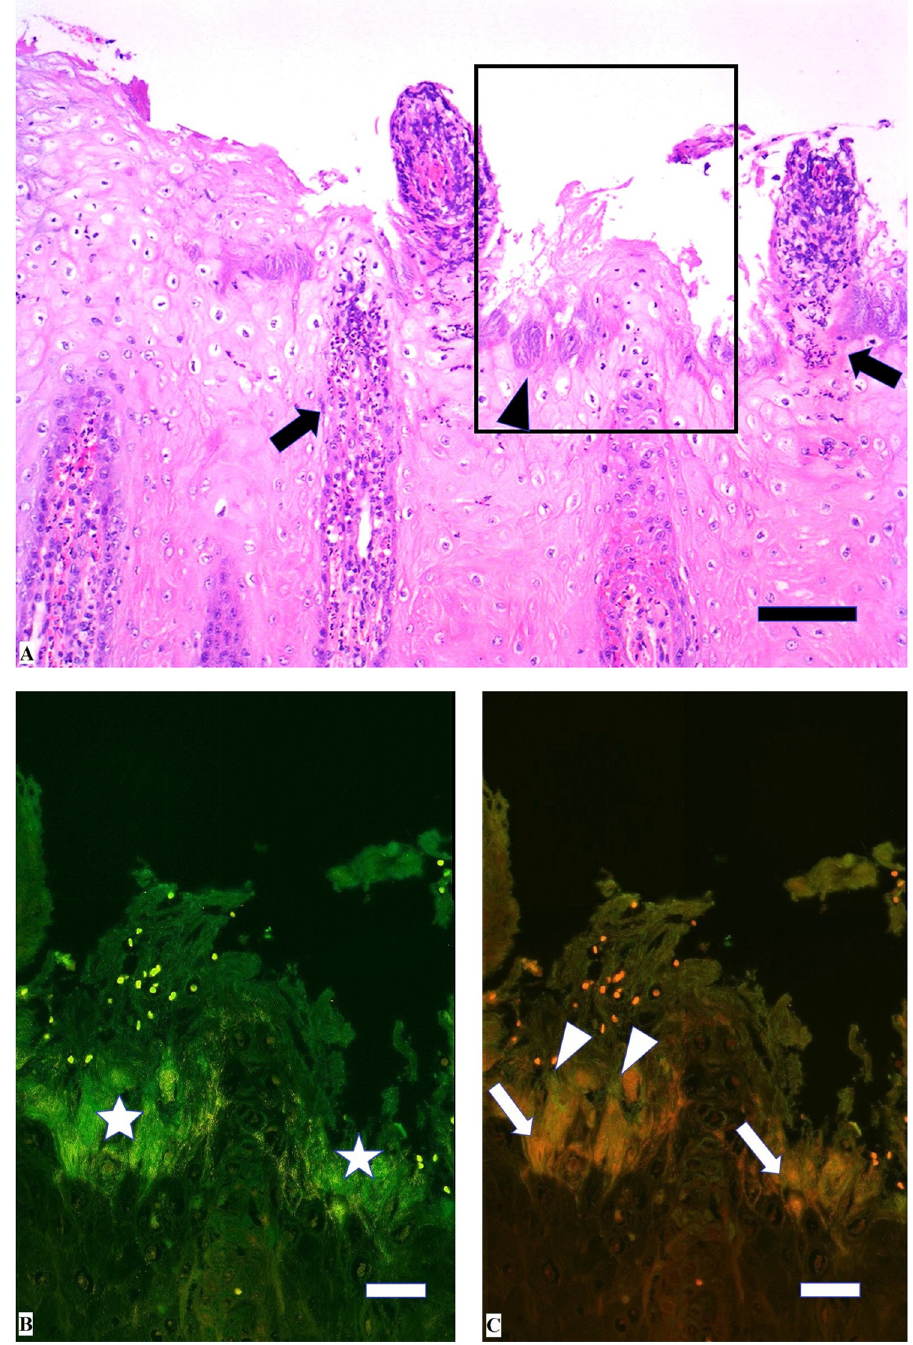
Fig 3. Histological appearance of interdigital skin of European bison ( Bison bonasus ) with digital dermatitis. Left hind foot of animal no. 7. A: The dermatitis is characterized by epithelial acanthosis, ballooning degeneration of keratinocytes and elongated, dermal papillae containing mixed cellular infiltrate (arrows) protruding to the surface. Large amounts of basophilic bacteria are infiltrating the superficial epidermis (arrowhead). H&E, bar 100 μ m. Rectangle shows selected area for in situ hybridization on a parallel section. B: Bacteria visualized as bright green organisms ( � ) infiltrating the superficial epidermis. Fluorescent in situ hybridization. Bar 25 μ m. C: Treponema organisms (arrows) infiltrating deep into the epidermis whereas other bacteria (arrowheads) are seen superficially. Double fluorescent in situ hybridization with probe for genus Treponema (Cy3 labelled) and for domain Bacterium (fluorescein labelled). Bar 25 μ